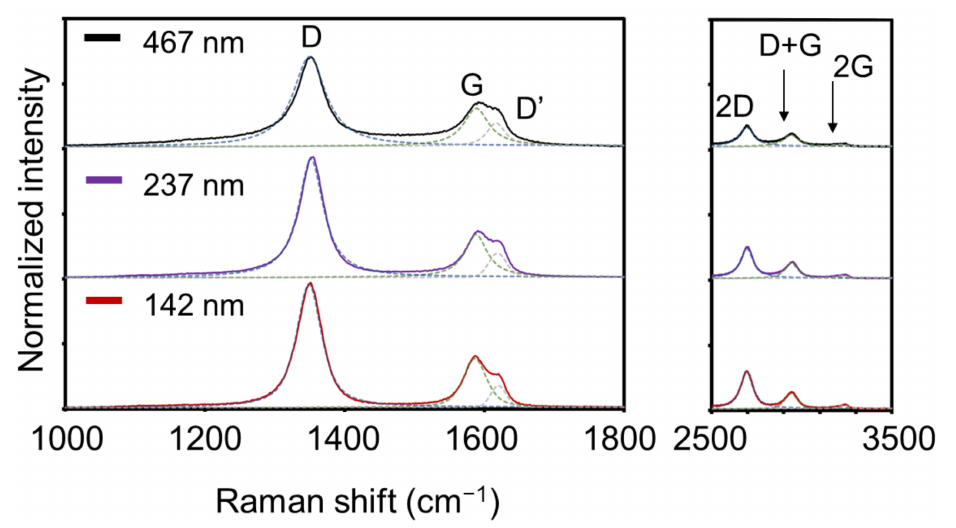
Figure 2. Raman spectra of CNWs with wall-to-wall distances of 142, 237, and 467 nm synthesized at V in of 0, 90, and 120 V, respectively.